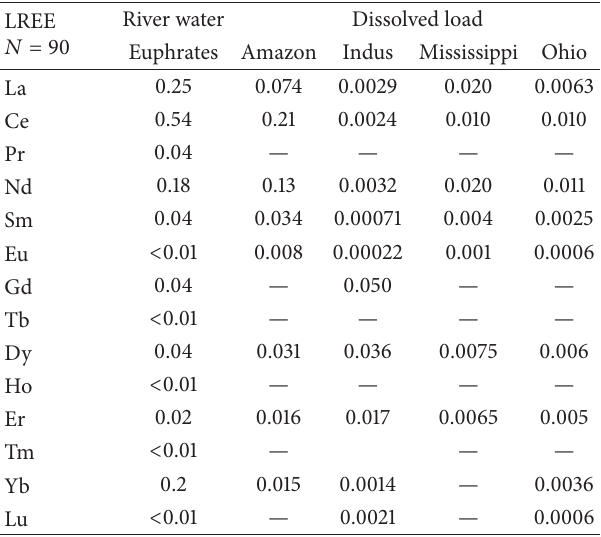
Table 2: North American Shale (NAS), upper continental crust (UCC), and chondrite (Ch.) from Yang et al. [8], Condie [22], Taylor et al. [23], and Sholkovitz [50, 51] and normalized REE summary statistical values (ppm) in Euphrates River sediments; ∗ Obaje et al. [18]. LREE Mean St. dev. La/NAS 0.28 — La/UCC 0.29 — — La/Ch. Ce/NAS Ce/UCC Ce/Ch. Pr/NAS — Pr/UCC 0.31 — Pr/Ch. Nd/NAS Nd/UCC 0.30 0.06 — — Nd/Ch. 14.26 — Sm/NAS 0.38 0.11 — — Sm/UCC 0.48 0.14 — — Sm/Ch. 10.20 3.00 — Tm/Ch. — Eu/NAS 0.48 0.12 — — Eu/UCC 0.65 0.17 — — Eu/Ch. Gd/NAS — Gd/UCC 0.58 0.16 — — Gd/Ch. —